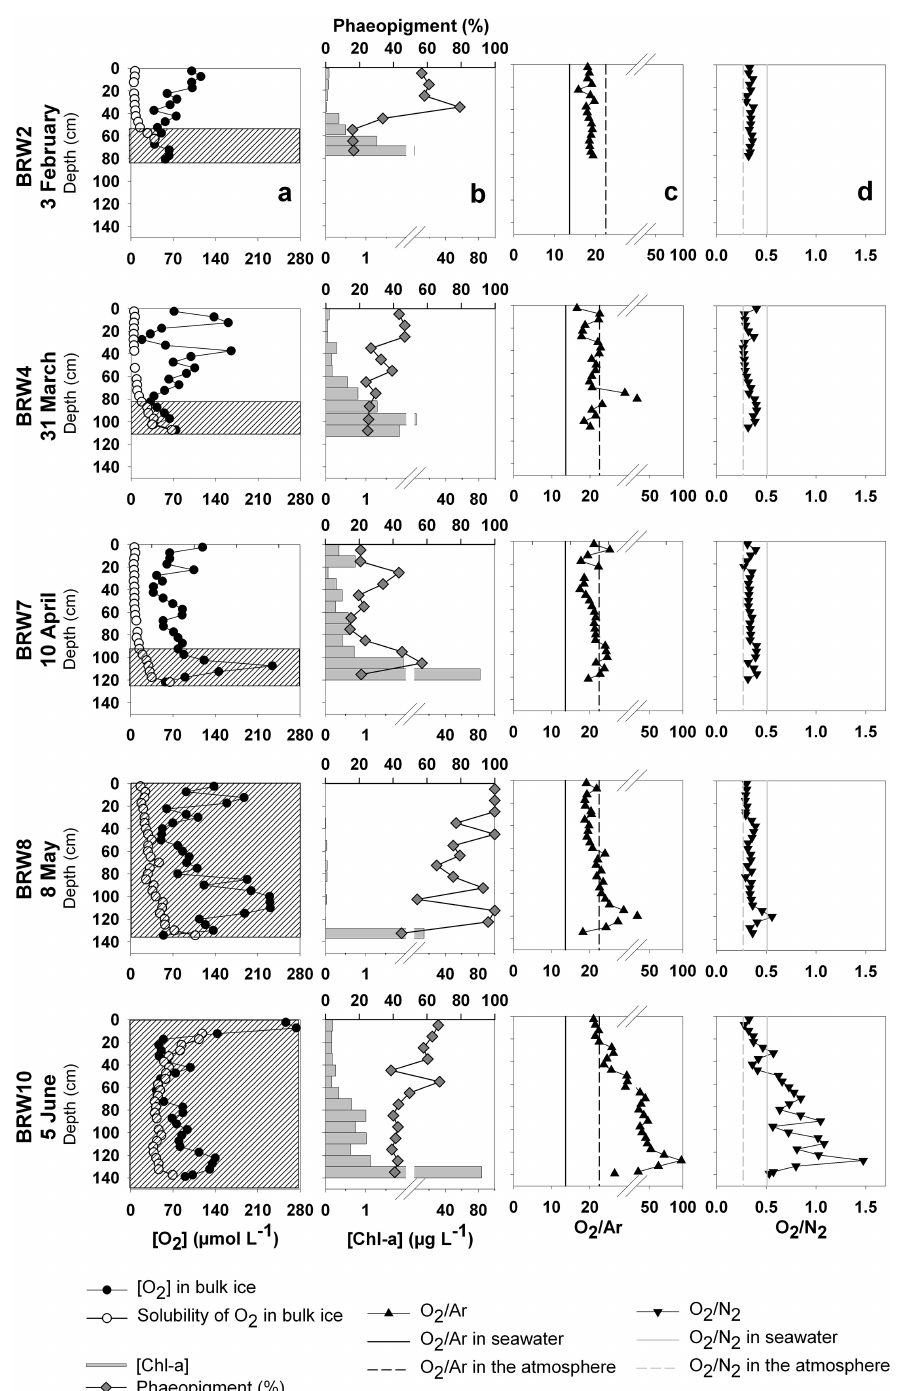
Figure 5. (a) O 2 concentration in bulk ice (black dots) compared to its solubility in ice (white dots), the dashed areas refer to permeable ice layers (i.e., with a brine volume fraction above 5%); (b) chl a concentrations in ice(horizontal bars) with a break at 2µgL − 1 compared to the percentage of phaeopigments (diamonds); (c) O 2 /Ar in ice (upside triangles) with a break at 25, compared to the same ratios in seawater (straight black line) and in the atmosphere (dashed black line); (d) O 2 /N 2 in ice (downside triangles) compared the same ratios in seawater (straight grey line) and in the atmosphere (dashed grey